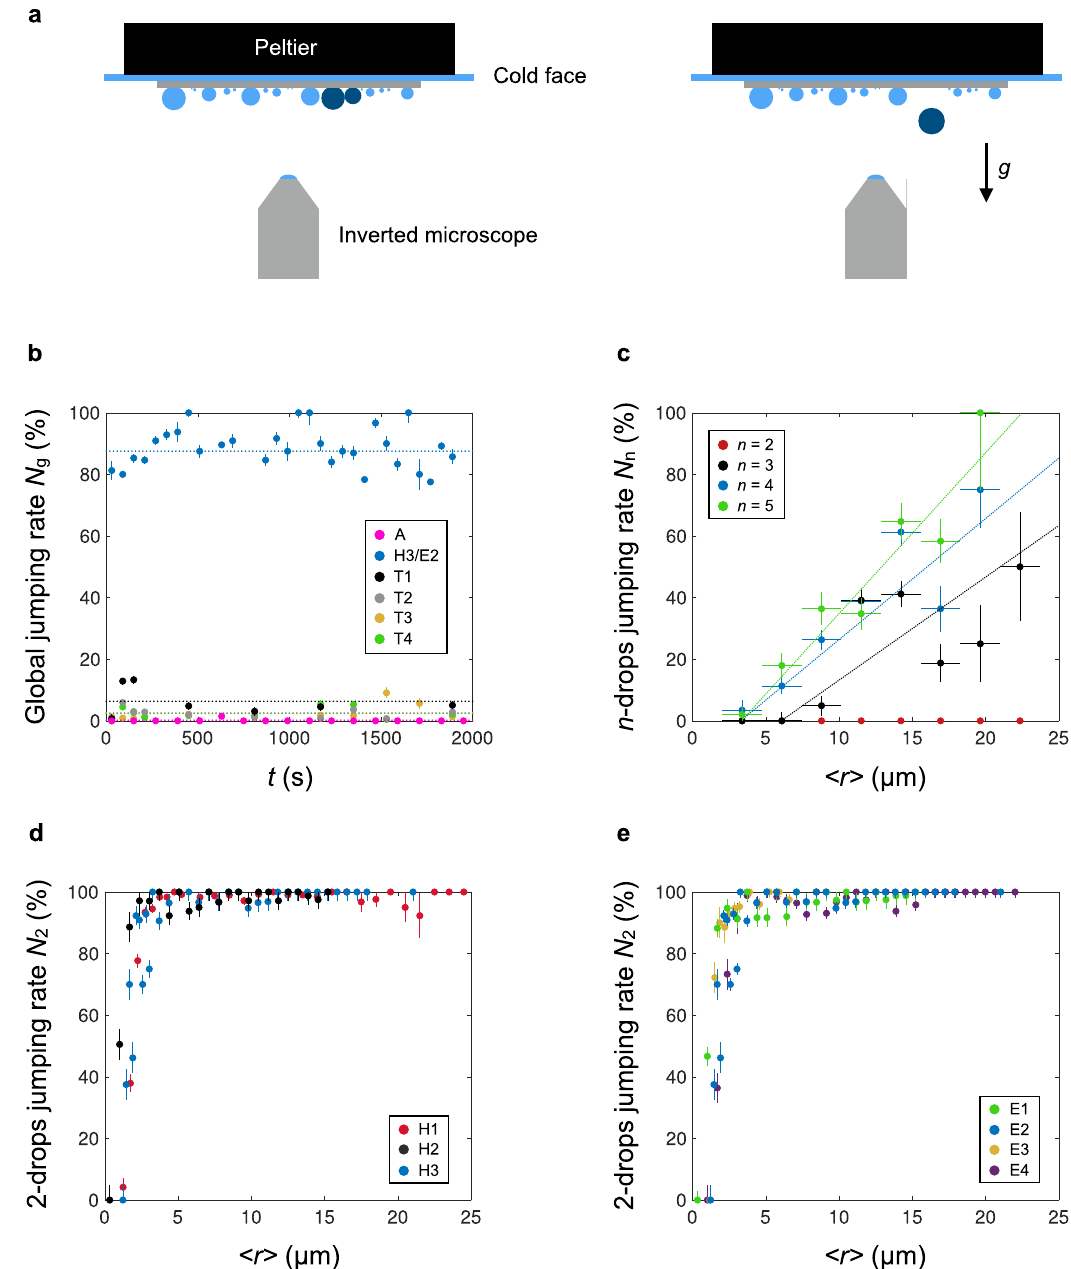
Fig. 4 Antifogging ability of nanocones. a Schematic of the experiment: a sample is placed upside down on a Peltier cooler, which generates dew from atmospheric water. Droplets nucleate, grow and eventually coalesce, which we observe with an inverted optical microscope. We focus in particular on coalescing droplets (dark blue) and their possible takeoff from the material, from which we deduce the jumping rate of merging drops. b Global jumping rate N g as a function of time t : we consider all observed coalescences and average the proportion N g that results in droplet jumps after merging, over 1 min. For each series of data (obtained with pillar texture A, conical texture H3/E2 and truncated texture T1 to T4), we indicate with a dotted line the average value of N g . The pink dots on the bottom show the jumping rate N g = 0.2% for sample A. c Jumping rate N n of droplets on truncated cones T1 as a function of the mean radius < r > of merging drops, after distinguishing the coalescences that imply n = 2, 3, 4, or 5 droplets. N n increases with both n and < r >, explaining why a modest value of N g can be accompanied by good antifogging abilities. Dotted lines are guides for the eyes. d , e . Jumping rate N 2 on sharp cones H/E for symmetric binary coalescences, for which merging radii do not differ by more than 20%. N 2 is plotted as a function of the average radius < r > for homothetic nanocones H1 – H3 in d and for extruded cones E1 – E4 in e . In both cases, the jumping rate plateaus at a constant value of 99 ± 1% above a critical radius r c ≈ 1.5 ± 0.4 µ m. Error bars represent the standard deviation of